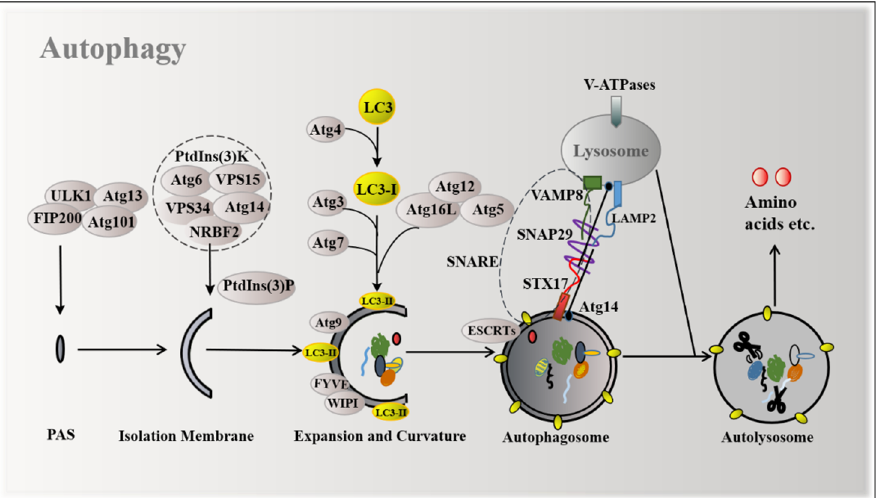
Figure 1. Mechanisms of autophagy induction. The ULK1 complex, PtdIns(3)K complex, and two ubiquitination systems are involved in the formation of autophagosomes. Atg14 promotes the formation of STX17-SNAP29-VAMP8-reconstituted proteoliposomes to form autolysosomes.